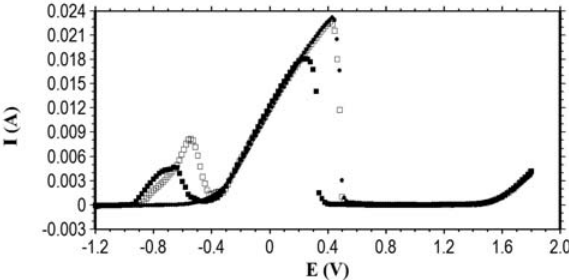
Fig. 5. The linear sweep voltammograms recorded for CS ( (cid:2) ), CS/ZnNi ( (cid:3) )CS/ZnNi/PNMP ( (cid:4) ) electrodes in 0.05 M EDTA con- taining 0.50 M sodium sulphate